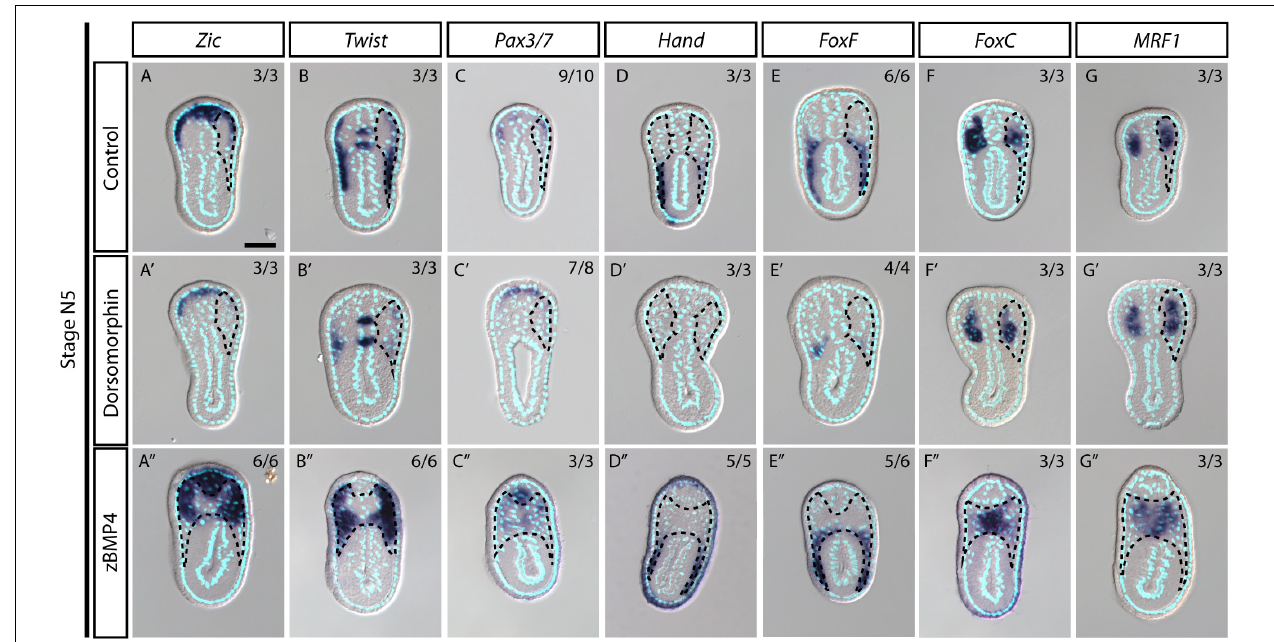
FIGURE 6 | Medial-lateral patterning of amphioxus somites is controlled by the level of BMP signaling. (A–G) Cross sections of N5 stage embryoes treated with DMSO as a control group. Scale Bar, 25 µ m. (A (cid:48) –G (cid:48)(cid:48) ) Cross sections of N4 stage embryos treated with inhibitor Dorsomorphin or recombinant zBMP4 protein at G4 stage. Dotted black outline marks one side of the somite. Whole somite areas are marked in panels (A (cid:48)(cid:48) –G (cid:48)(cid:48) ) , as left and right somites are not readily discernible. Left and right sides of somites exhibit left-right asymmetry as the left amphioxus somite approximately half a segment staggered more anteriorly to the right somite. Numbers on top right: denominator represents the total number of embryos that are sectioned at approximately 6th to 8th somite level as shown in Supplementary Figure 2 , numerator shows the number of embryos which show the displayed phenotype when sectioned. DMSO control is used as the count number for the control column. BSA treated whole mount embryos are shown in Supplementary Figures 5 – 8 . Whole mount embryos used from experiment are displayed in Supplementary Figures 5 – 8 , sections are obtained from 6th to 8th pair somite, as indicated by the white brackets drawn in Supplementary Figure 2